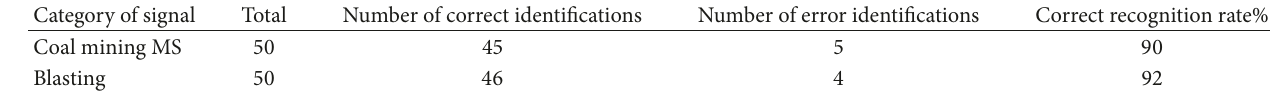
Table 6: Identification results of training